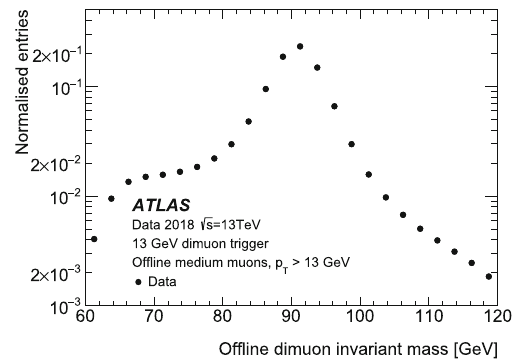
Fig. 20 The offline dimuon invariant mass from events passing the analysis selection from the dimuon performance trigger. For the perfor- mance triggers, the RoIs used by the fast and precision tracking are the same and as such the offline dilepton candidates chosen for the analysis of the fast and precision tracking are